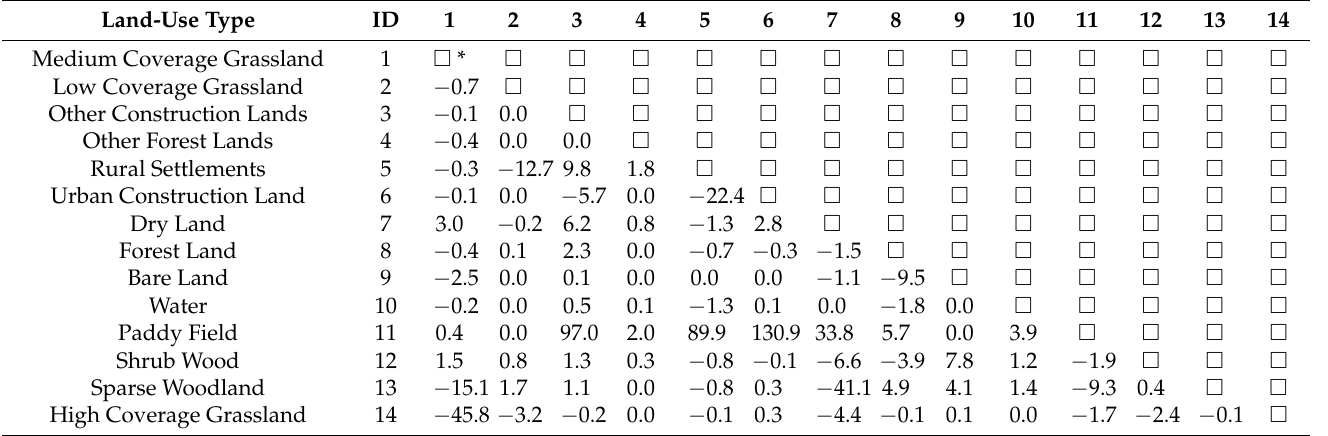
Table 4. Net change of land-use structure in the “Western Protected Area” from 2000–2020 (km 2 ). Land-Use Type